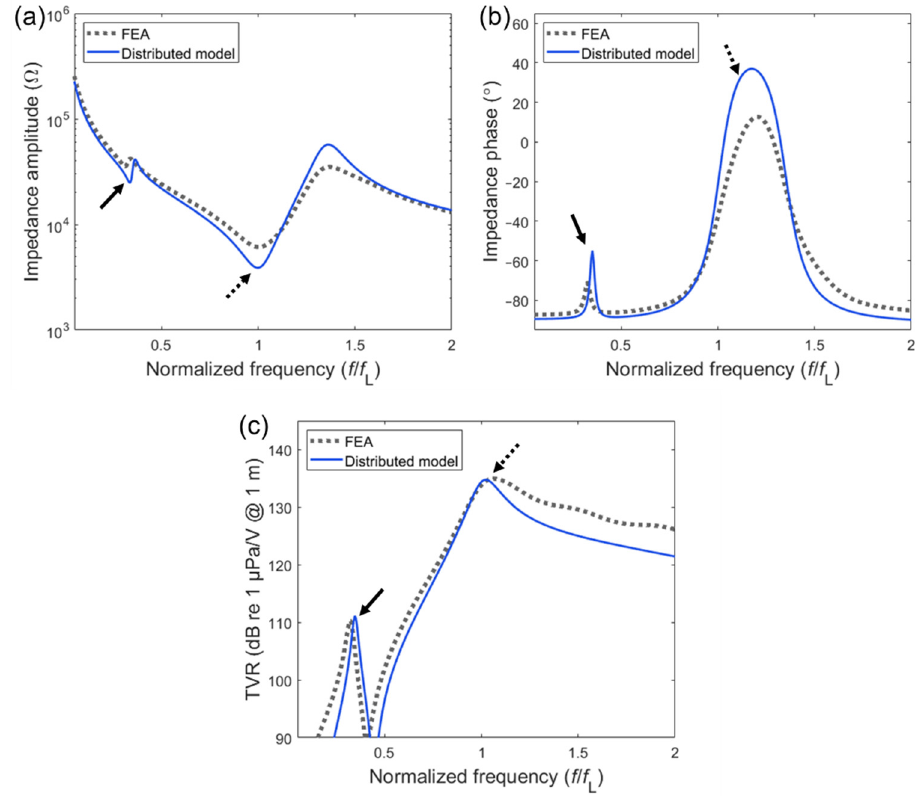
Figure 4. Equivalent circuit and finite element analysis (FEA) simulation of the electrical impedance and the transmitting voltage response (TVR) of the rear-mounted design: ( a ) impedance amplitude spectra; ( b ) impedance phase spectra; ( c ) TVR spectra. The suspension-induced peaks are marked by solid arrows while the fundamental resonance peaks are depicted by dotted arrows.